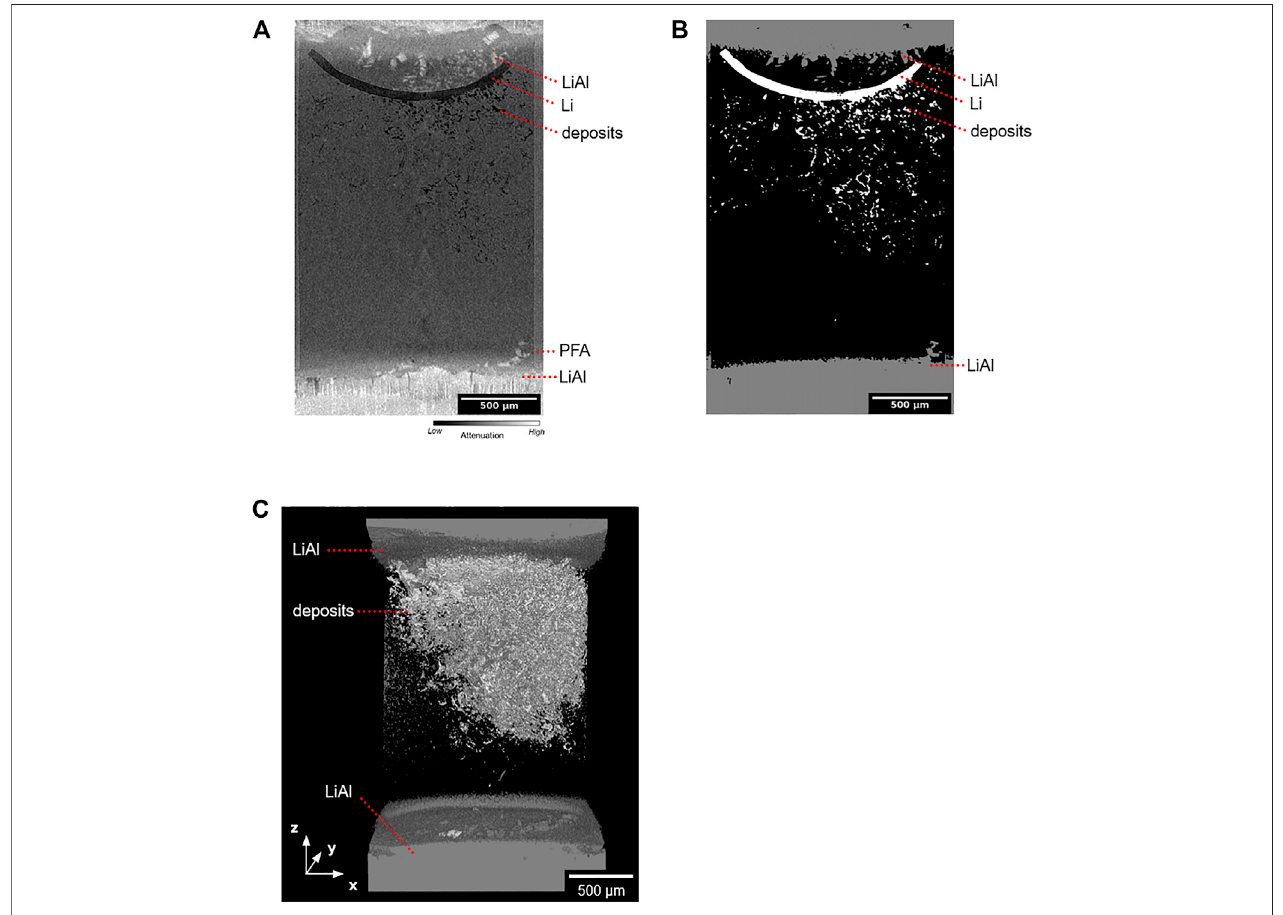
FIGURE 6 | Typical image of the cycled 6 Li – Li Cell_ A recorded at room temperature from (A) laboratory X-ray tomography imaging, (B) segmented slice, and (C) volume rendering from the segmentation process.